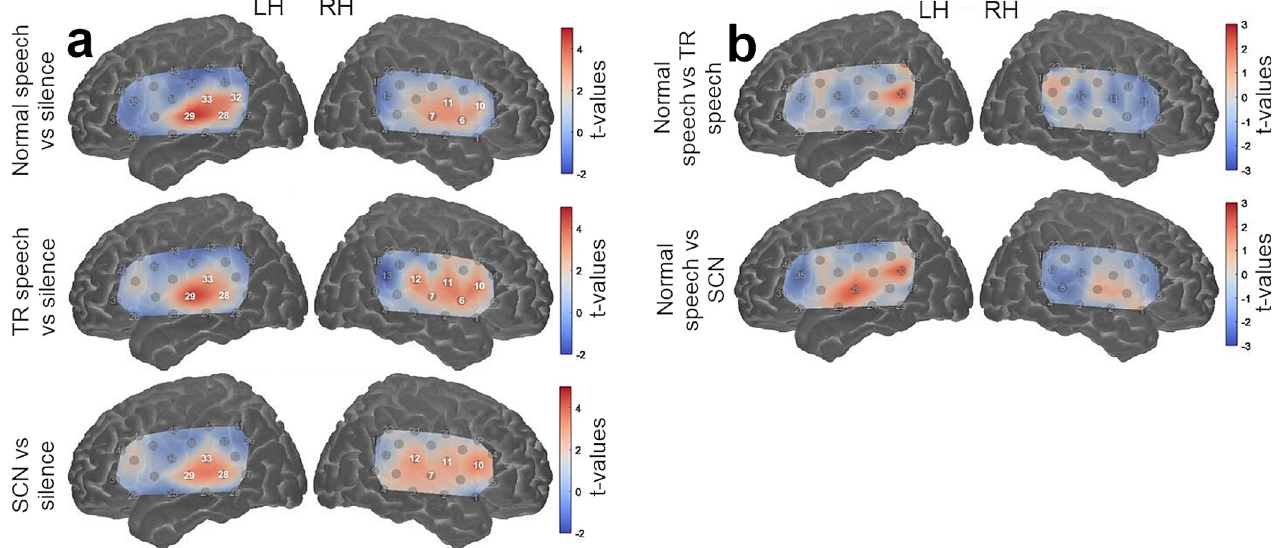
Fig 2. Group level cortical activation maps for each experimental contrast in the LH and the RH. Highlighted channels show significant activation (q < .05, FDR corrected). (a) Shows responses to the three auditory conditions (normal speech, TR speech and SCN) contrasted against silence. (b) Shows responses to normal speech contrasted against the two auditory baselines (TR speech and SCN). Note that the maps are interpolated from single-channel results and the overlay on the cortical surface is for illustrative purposes only.